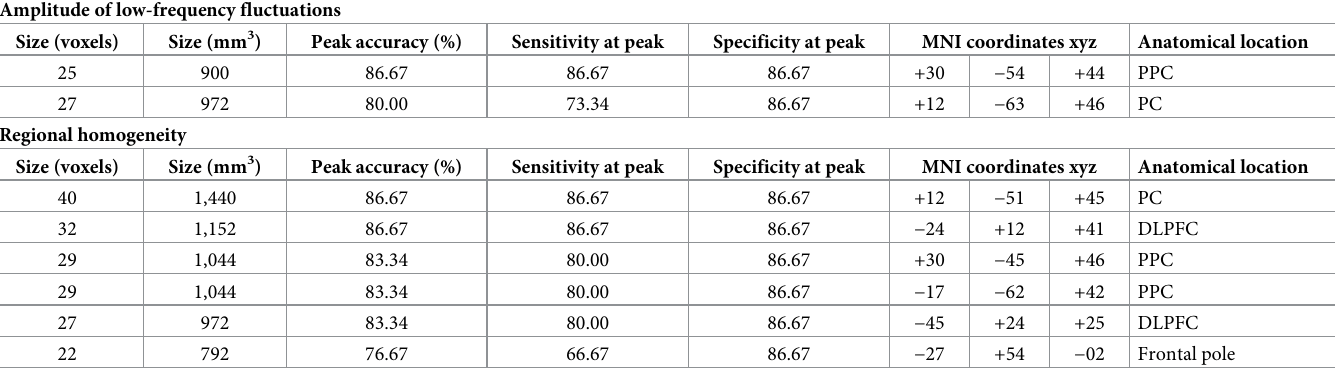
Our next step was to explore whether also the network-level hemodynamic activity of the future dyscalculia group differed from controls. To this end, we examined the functional connectivity between each voxel and all other voxels of the brain without predefining seed regions by computing whole-brain degree centrality maps. These maps revealed a peak classification accuracy of 86.67% in the right orbitofrontal cortex and 83.34% in the right DLPFC, the left PC and the right cuneus ( P < 0.001, corrected by permutation testing) (Fig 2, Table 3). Table 2. Regional functional classification